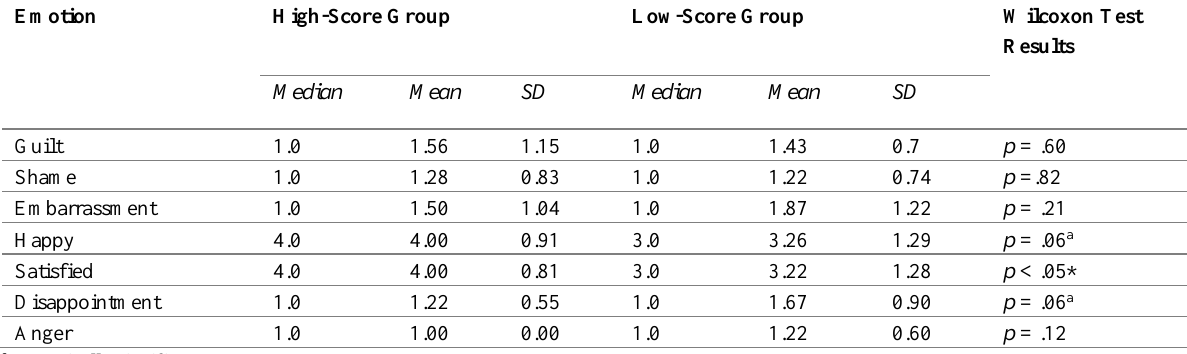
Table 1: Descriptive statistics for reported emotions between the two